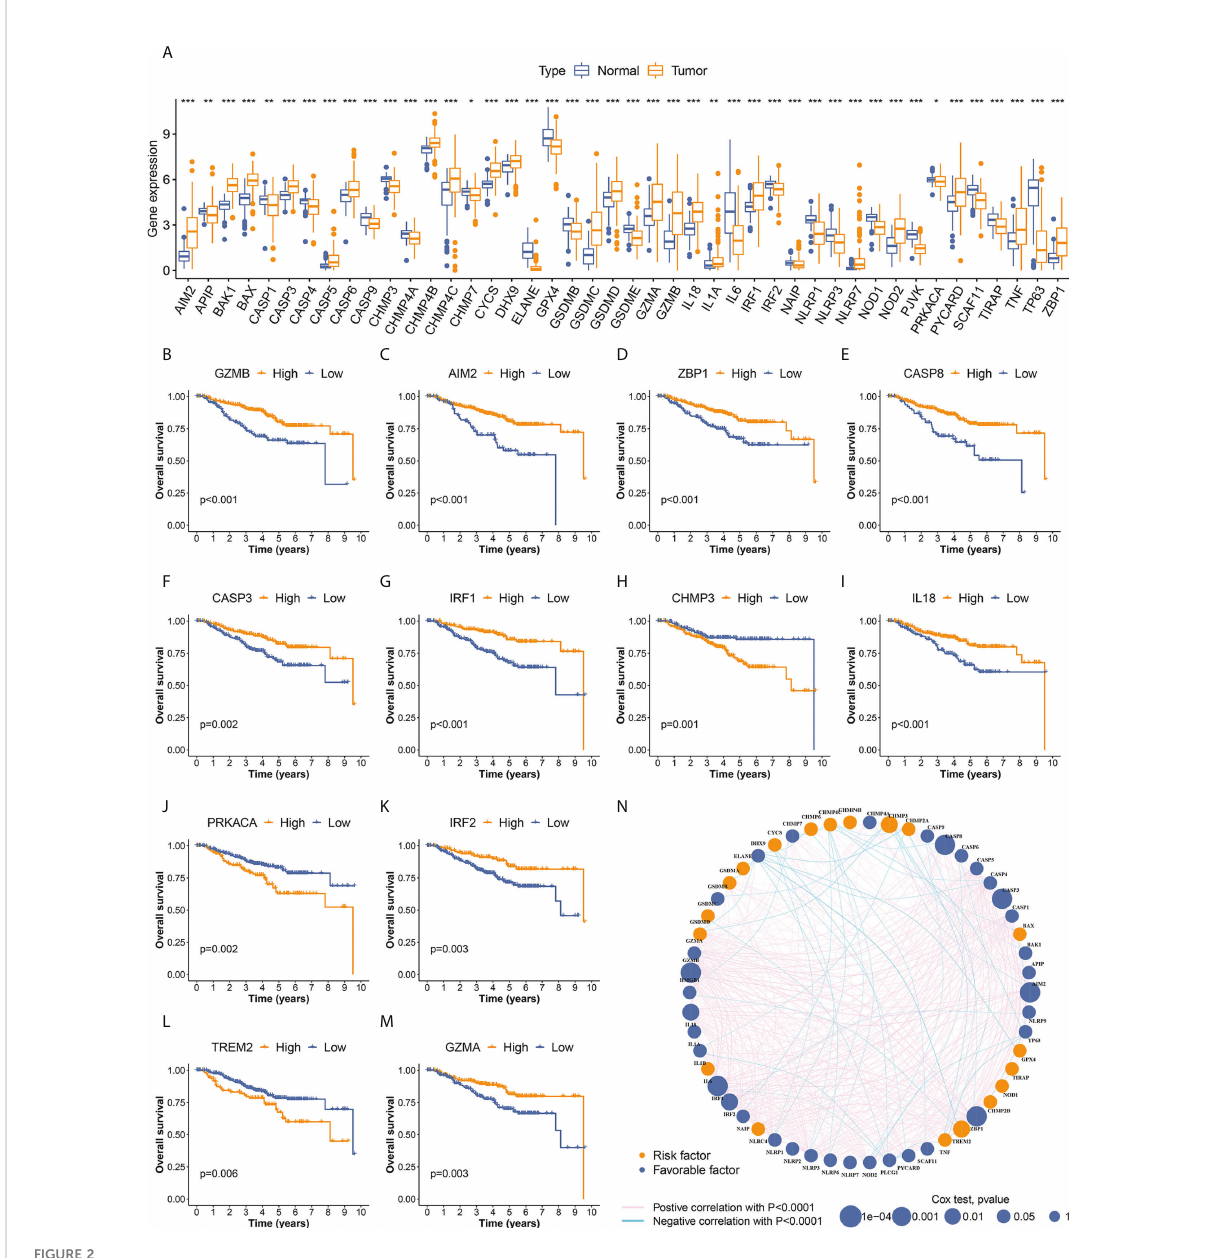
FIGURE 2 Identi fi cation of differentially expressed PRGs and OS-related PRGs in TNBC. (A) Differential expression was detected in 44 PRGs between cancer and normal samples. (B – M) PRGs signi fi cantly associated with overall survival of TNBC patients. Twelve OS-related PRGs showed statistical signi fi cance in both survival curves and Cox regression analyses. The other 19 OS-related PRGs with p<0.05 in Kaplan – Meier curves are illustrated in Supplementary Figure S1. (N) Interactive network and prognostic value of PRGs in TNBC. The thickness of green and pink lines represent the strength of interactive correlation between different PRGs. * p < 0.05, ** p < 0.01, *** p <